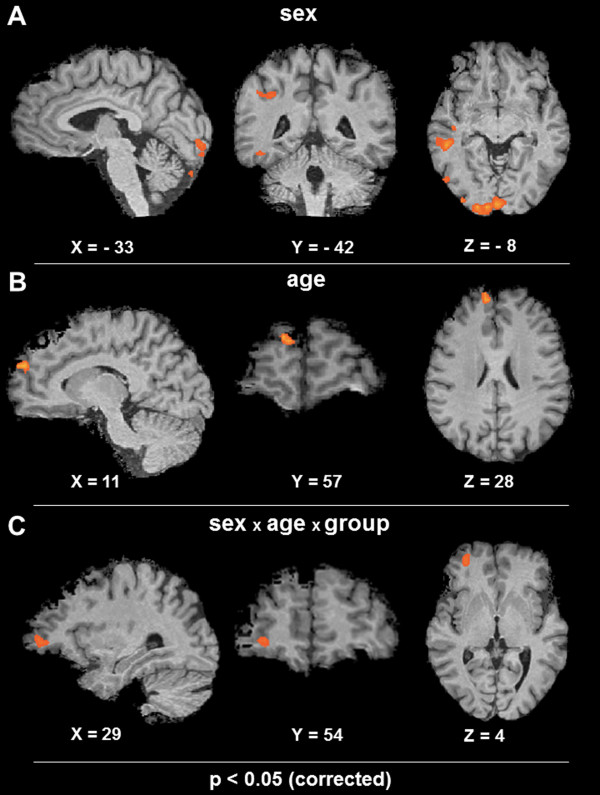
Whole brain ANOVA. Active voxels showed a main effect of the factor sex (female/male) in the right middle temporal gyrus, right fusiform gyrus, right inferior and middle occipital gyrus and right parietal lobe. In the left hemisphere the inferior occipital gyrus displayed active voxels (A). Furthermore we found bilateral activation in the cerebellum. The factor age (adult/child) showed an activation of the right dorsomedial prefrontal cortex (B). In the right lateral orbitofrontal cortex a significant interaction of sex, age and group was detected (C). Significant voxels in A-C represent effects at a corrected p-level of p < 0.05. X, Y, Z corresponds to the Tailarach coordinates.